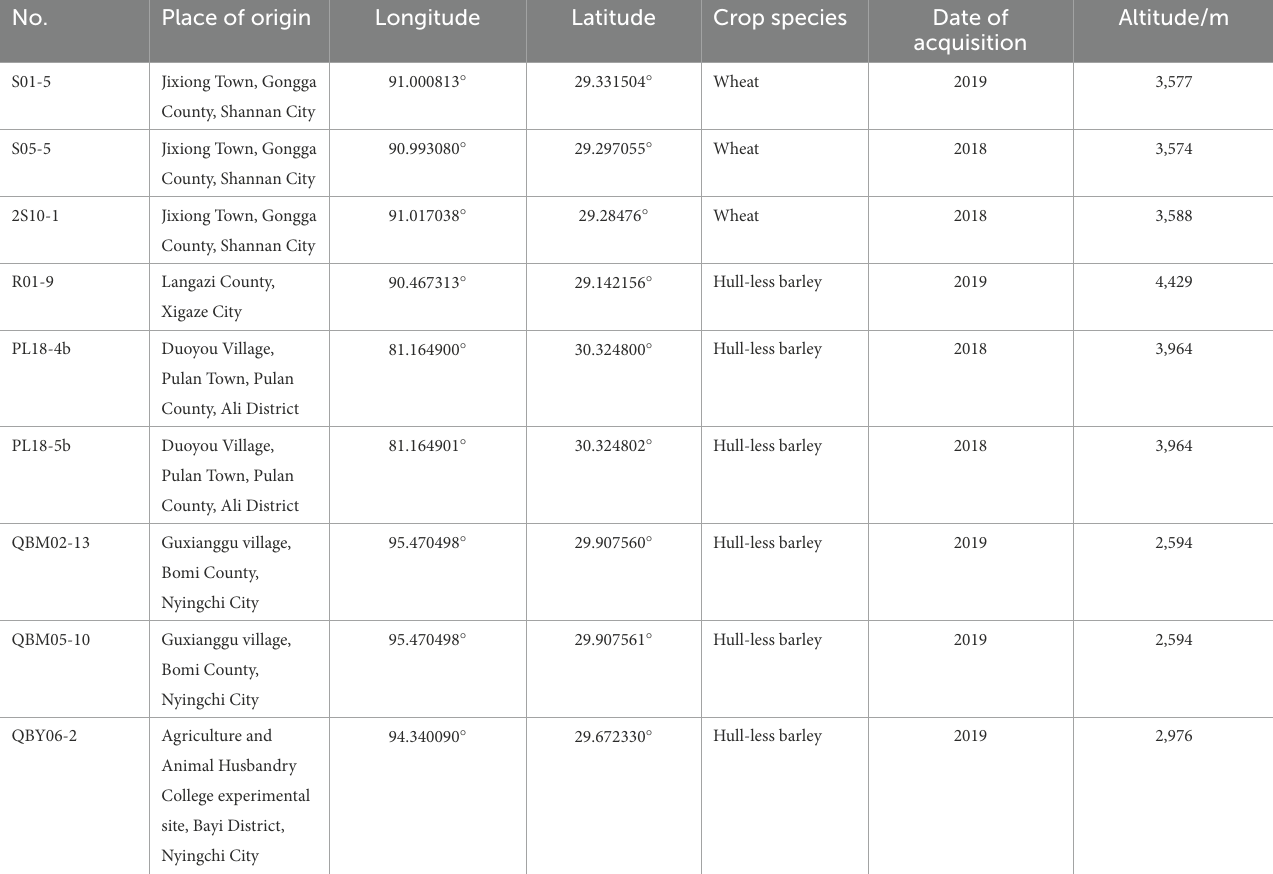
TABLE 1 The information of nine Alternaria alternata. No. Place of origin Longitude